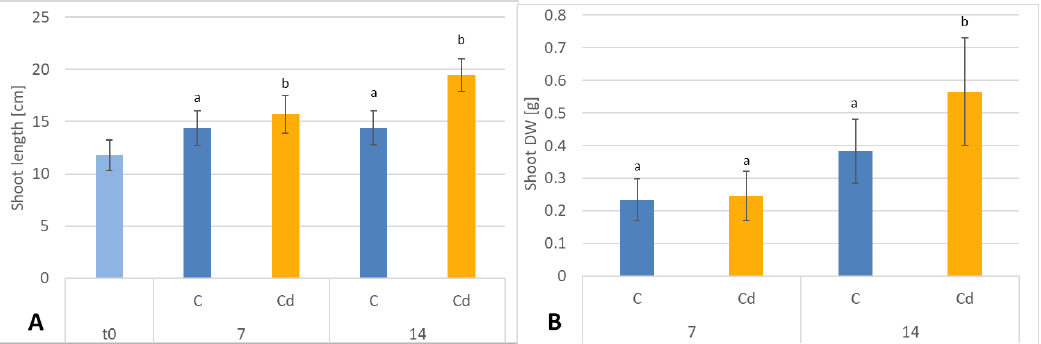
Figure 14. The length ( A ) and dry weight ( B ) DW of C. officinalis plant shoots. t0 (light blue bar)- shoot length of three-week-old seedlings. Bars which do not share a common letter are significantly different ( p < 0.05).